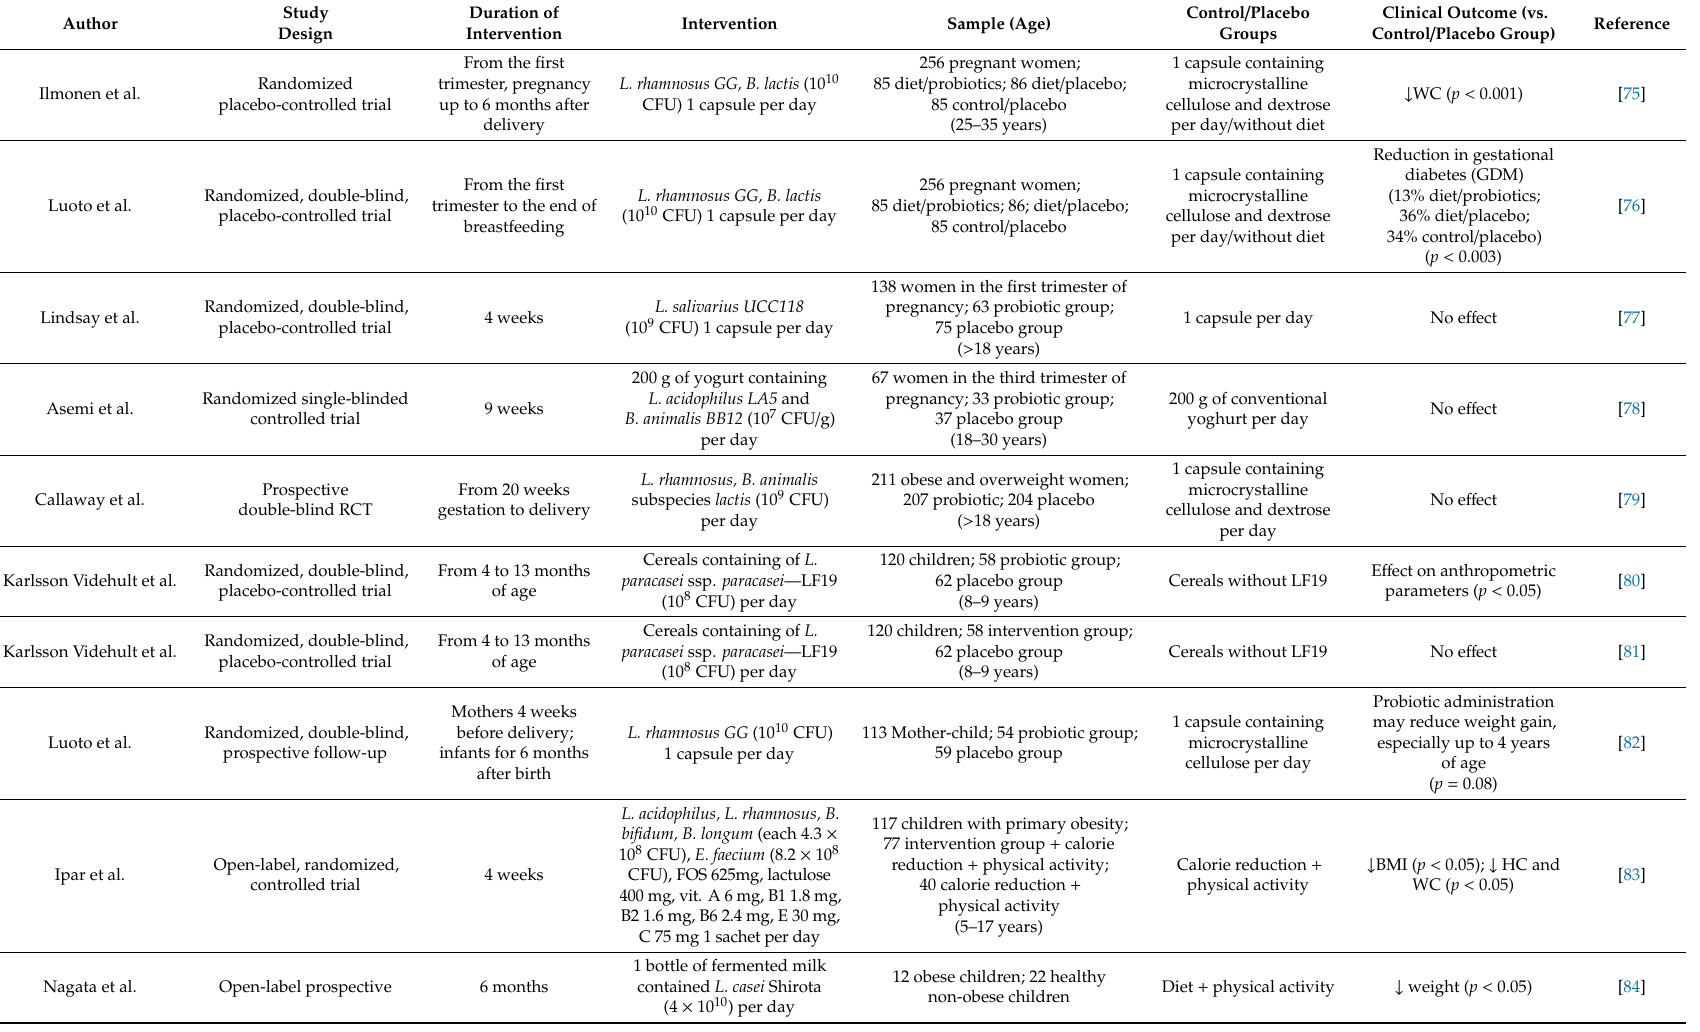
Table 2. Impact of probiotic supplementation on obesity and